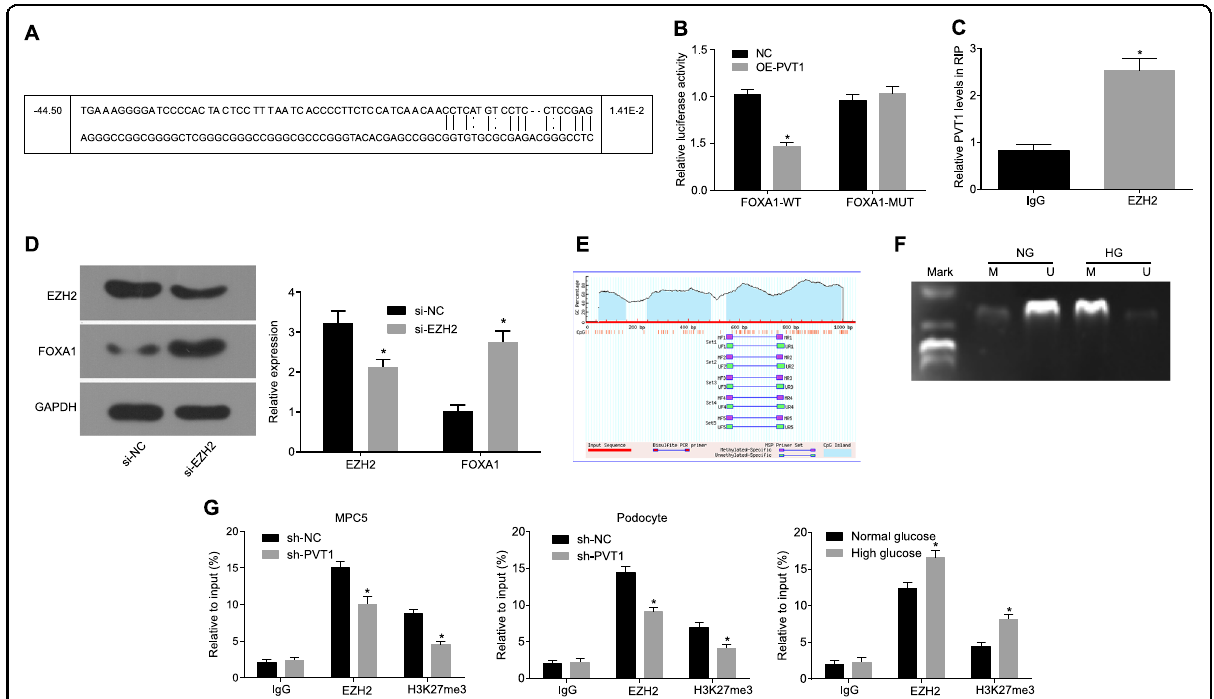
Fig. 3 LncRNA PVT1 inhibits the expression of FOXA1. a The target binding site between PVT1 and FOXA1 predicted by the biological prediction website microRNA.org. b The measurement of luciferase activity to verify the relationship of PVT1 and FOXA1; * p < 0.05 vs. the NC group; c the enrichment of IgG and EZH2 by PVT1; * p < 0.05 vs. IgG. d The protein levels of EZH2 and FOXA1; * p < 0.05 vs. the si-NC group. e The CpG island sites in the FOXA1 promoter region. f The methylation levels in cells cultured in HG medium and NG medium as detected by MSP assay. g The methylation level of EZH2 and H3K27me3 as detected by ChIP; * p < 0.05 vs. the sh-NC group. The measurement data are expressed as the mean ± standard deviation, and the comparisons between the two groups were analyzed by a t test. The experiment was repeated three times. LncRNA PVT1, long noncoding RNA plasmacytoma variant translocation 1; FOXA1, forkhead box A1; CpG, C-phosphate-G; NG, normal glucose; HG, high glucose; EZH2, enhancer of zeste homolog 2; IgG, immunoglobulin G; GAPDH, glyceraldehyde-3-phosphate dehydrogenase; NC, negative control; DN, diabetic nephropathy; MPC5, mouse podocyte clone